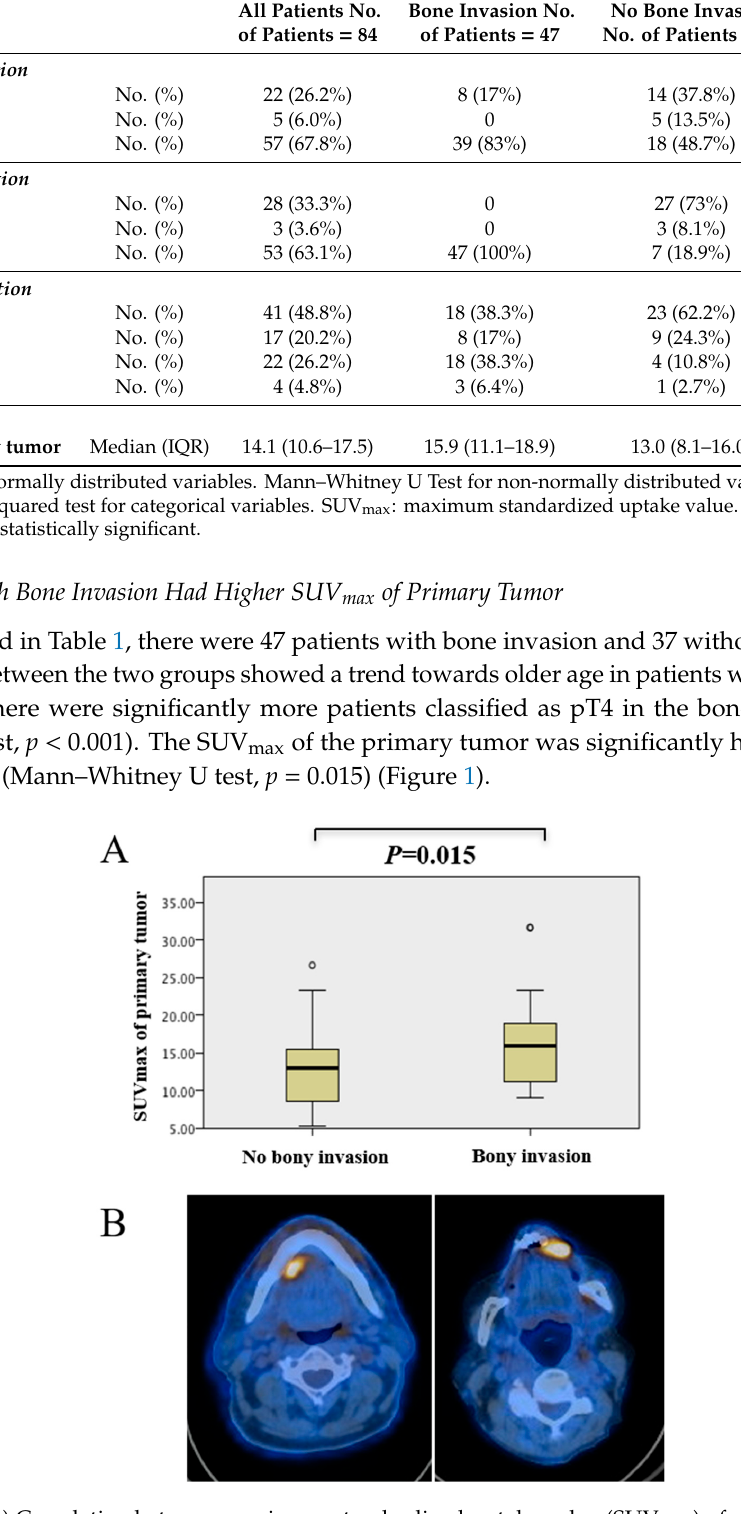
Figure 1. ( A ) Correlation between maximum standardized uptake value (SUV max ) of primary tumor and bone invasion. Oral squamous cell carcinoma (OSCC) with bone invasion showed a significantly higher SUV max (Mann–Whitney U Test, p = 0.015). ( B ) Representative axial fused FDG-PET/CT images showing, on the left, a tumor with a low SUV max (7.3). Histopathological analysis showed no bone invasion. On the right, the SUV max was 21.8, and the tumor showed bone invasion.